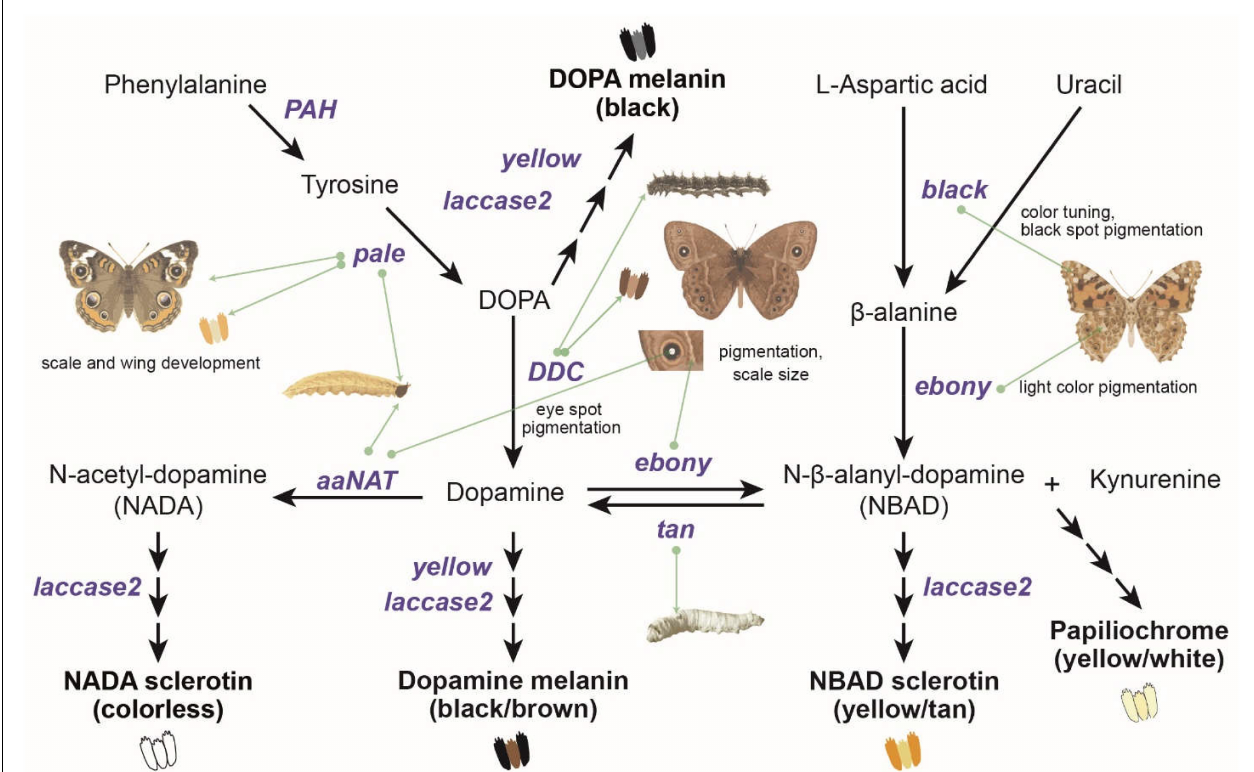
FIGURE 1 | Melanin pathway genes and their phenotypic effects in Lepidoptera. The proposed melanin pathway (Wright, 1987; Zhang et al., 2017a) illustrates the genes/enzymes (colored in purple) that catalyze different steps in the production of four major pigments. The end products of the pathway conjugate with sclerotin to produce differently colored scales (Vavricka et al., 2010), as illustrated. Each gene also regulates individual wing elements in different species of butterflies (green arrows), as deciphered from their knockout phenotypes (summarized in Supplementary Table S1